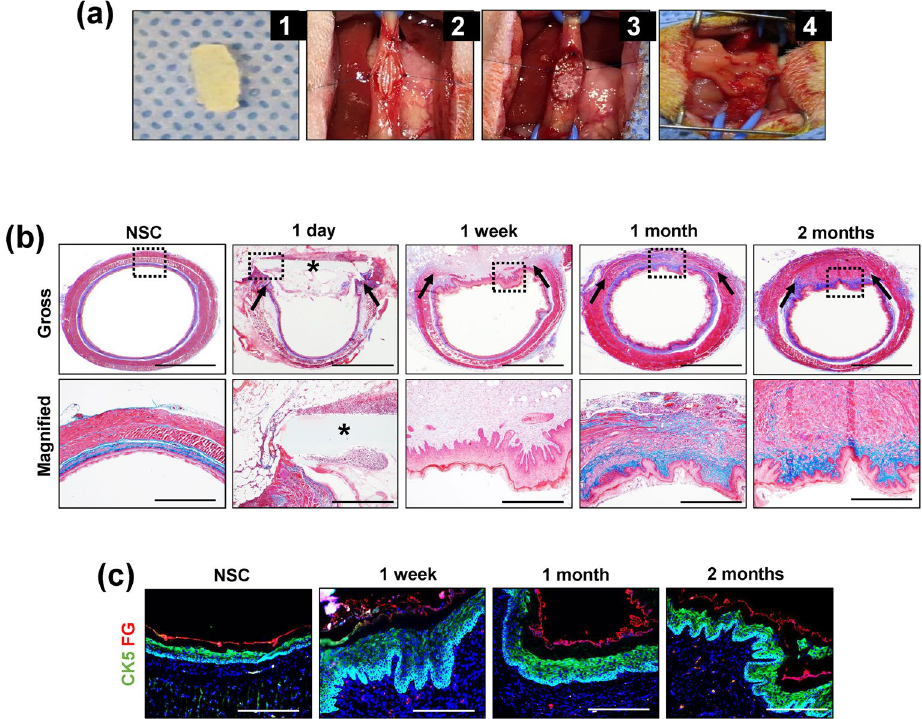
Figure 1. Onlay esophagoplasty model and histological and immunohistochemical analyses of constructive remodeling at implant sites. ( a ) Photomicrographs of various surgical stages of BLSF graft implantation into the rat esophagus. ( a1 ) BLSF scaffold (7 × 3 mm) prior to implantation. ( a2 ) Excision of native tissue and patch defect creation. ( a3 ) Anastomosis of BLSF graft (S) into the esophageal defect. ( a4 ) Implant area covered with omental patch tethered to esophageal adventitia prior to abdominal and skin closure. ( b ) Representative photomicrographs of gross and magnified (bracketed fields in top row) esophageal cross-sections stained with Masson’s trichrome from nonsurgical controls (NSC) and rats subjected to onlay esophagoplasty with acellular grafts and harvested at study timepoints. Scale bars = 1.25 mm (top row) and 750 μm (bottom row). Asterisks denote scaffold fragments and arrows demarcate anastomotic borders of the original implantation site. ( c ) Representative photomicrographs of epithelia in NSC and neotissues supported by acellular grafts demonstrating protein expression of cytokeratin (CK)5 and filaggrin (FG). For all panels, respective marker expression is displayed in red (FG) or green (CK5) while DAPI nuclear counterstain is detailed in blue. Cyan coloring is a consequence of merging CK5 and DAPI staining. Scale bars = 200